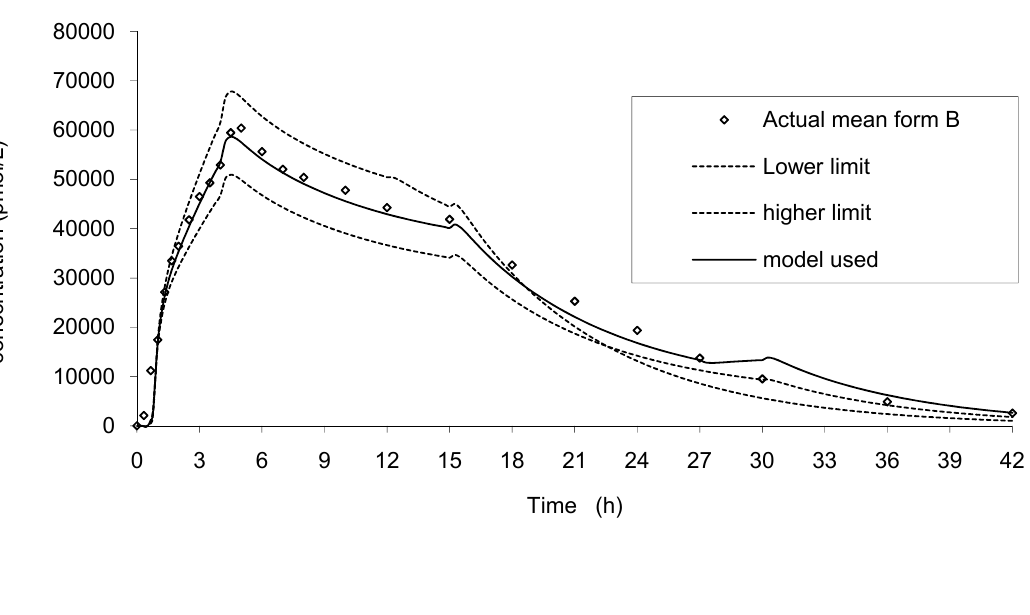
Figure 11. In vivo prediction of formulation B based on the lower and upper dissolution limits to ensure